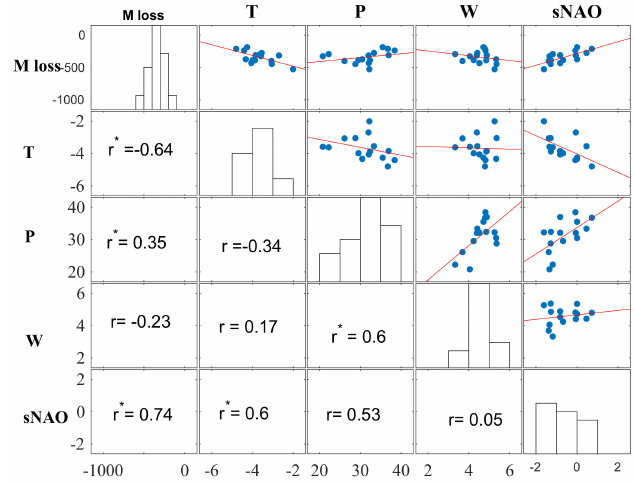
Figure 8. Correlation of the summer NAO index and the summertime mass losses from the GRACE products. The correlation r* represents the p -value < 0.05, and the correlation r indicates the p -value >